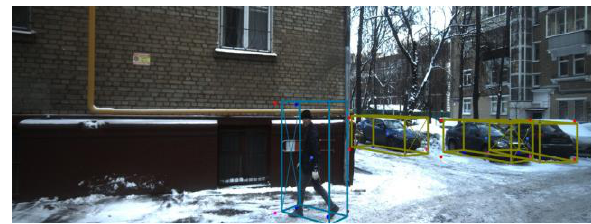
Figure 5 . The result of the semantic segmentation and dense stereo reconstruction algorithm.